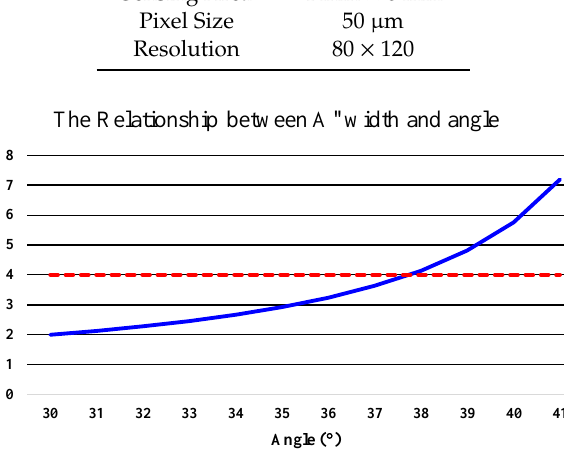
Figure 2. The blue line shows the enlarged relationship between A’’ and the angle of the reflecting surface. The red line shows the limitation of CMOS.